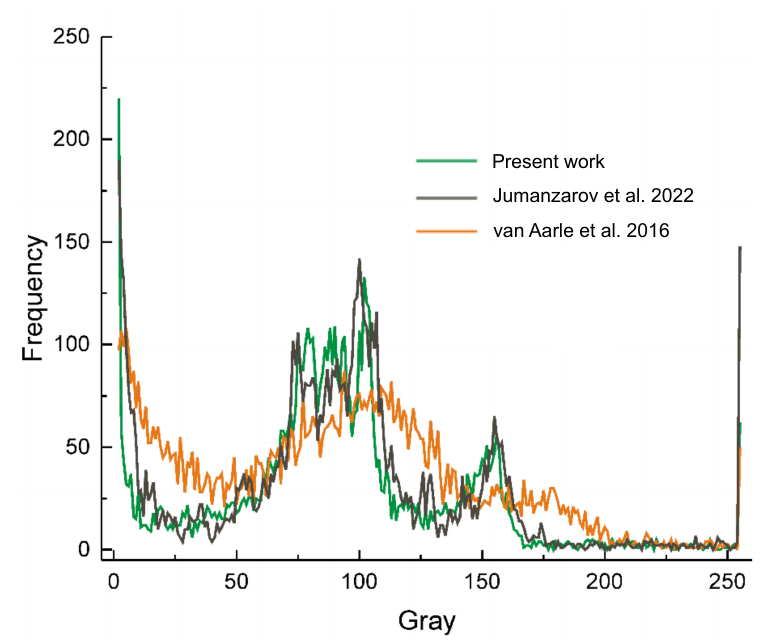
Figure 5. The histograms of CT images reproduced in Figure 4, e.g., present work algorithm (Figure 4b), Jumanzarov et al. [22] (Figure 4c) and van Aarle et al. [35] (Figure